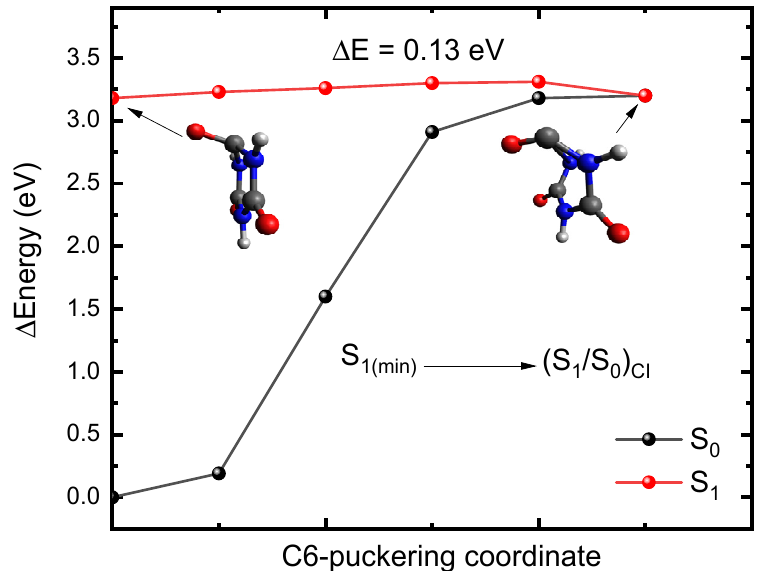
Figure 6. Potential energy profiles based on the minimum-energy paths between the S 1 minimum- geometry and the (S 1 /S 0 ) CI found using SF-TD-DFT along the C6-puckering coordinate obtained for CA at the TD-X3LYP/C-PCM/cc-pVDZ in water. Inset: Molecular structure of the S 1 minimum- geometry and the (S 1 /S 0 ) CI . ∆ E represents the energy barrier to access the conical